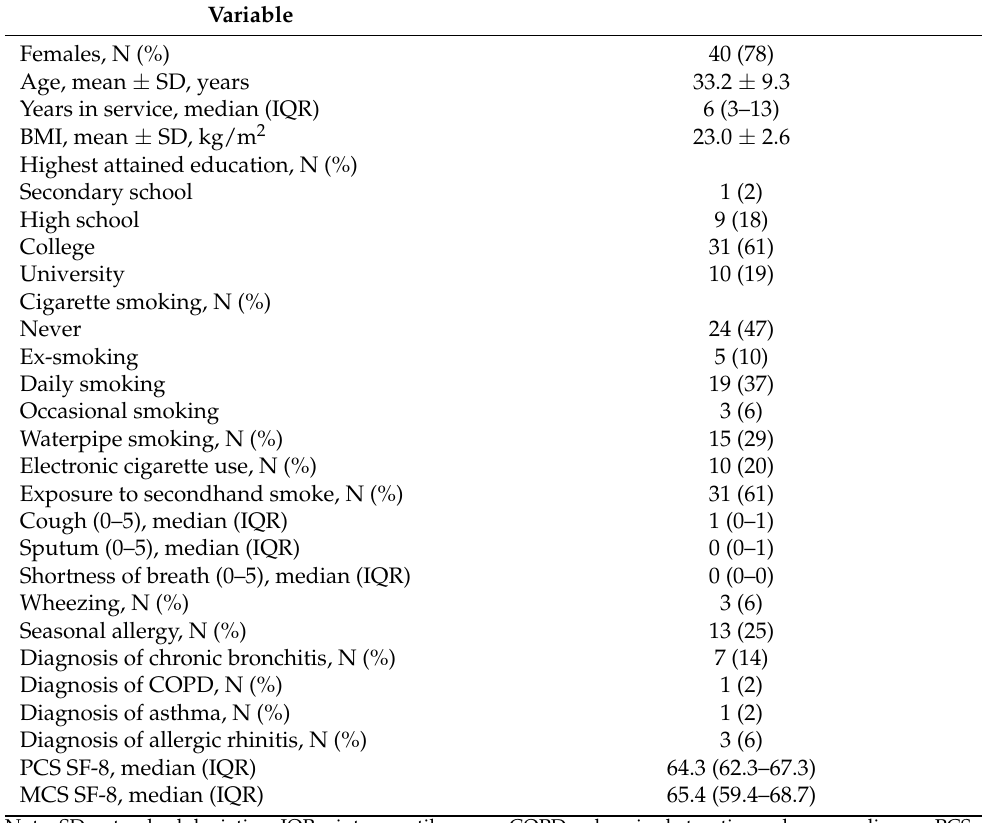
Table 2. Demographic and lifestyle profile of the salon personnel along with diagnoses and health- related quality of life.